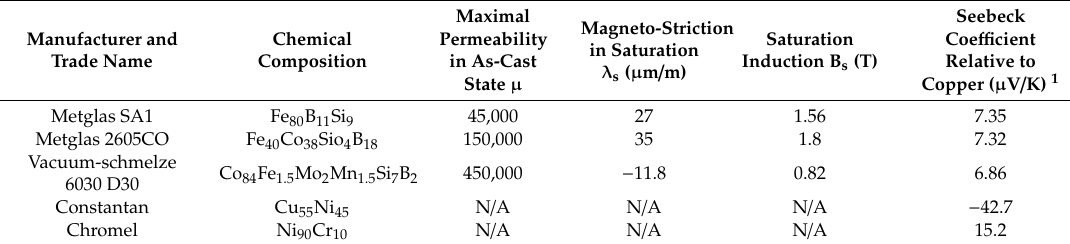
Table 1. Essential parameters of investigated samples.